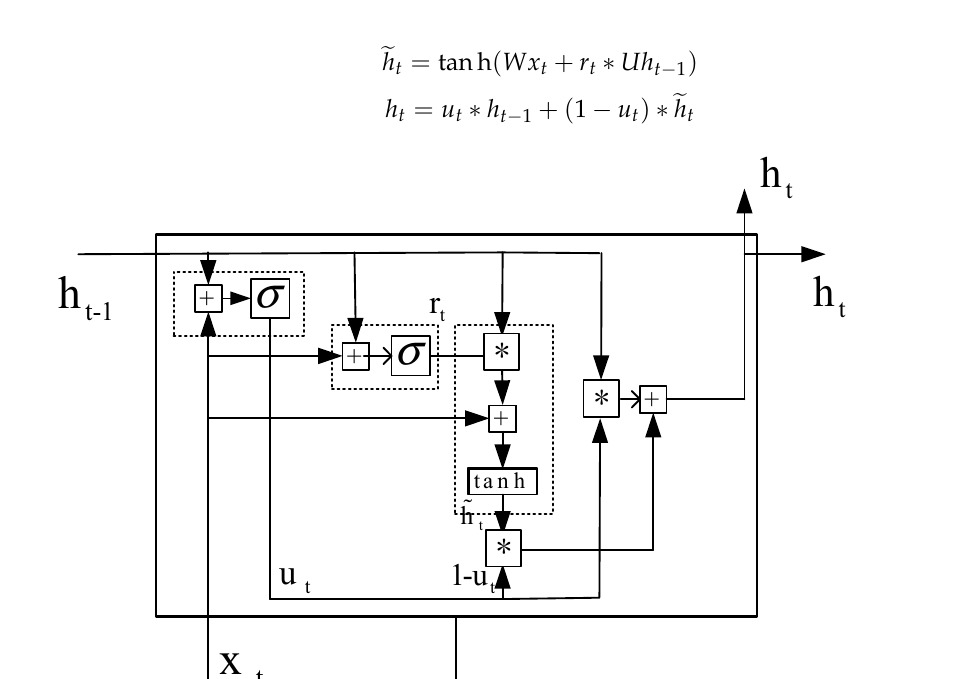
Figure 6. Unit of GRU model. ‘*’ represents convolution operation.